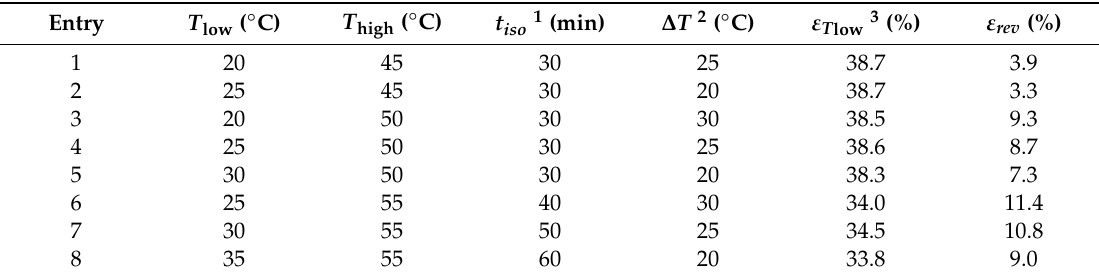
Table 5. Bidirectional actuation of PEUU foam under constant load conditions ( σ = 16.8 kPa) in application-adapted temperature ranges.